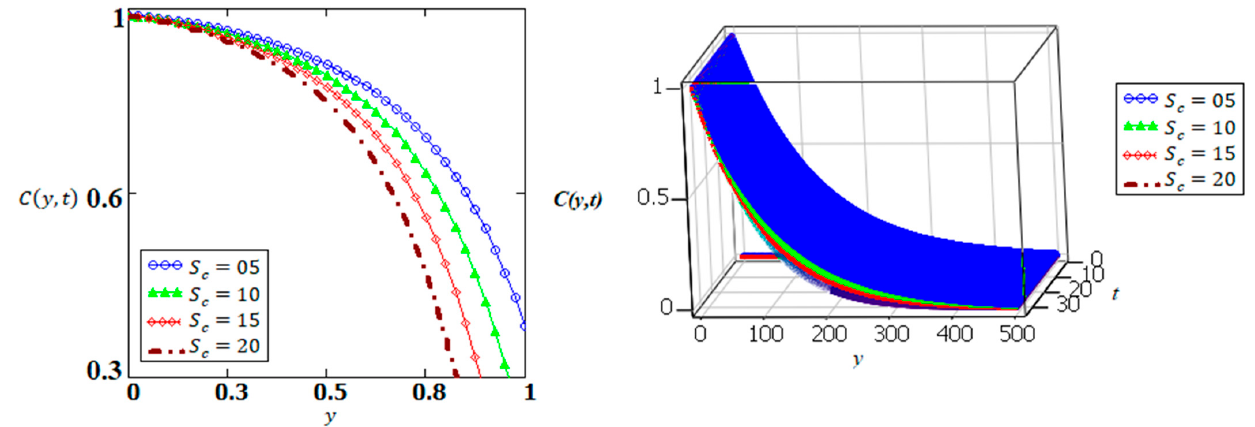
Figure 2. Effective role of temperature distribution depicted from Equation (12) for 𝑃 (cid:3045) .